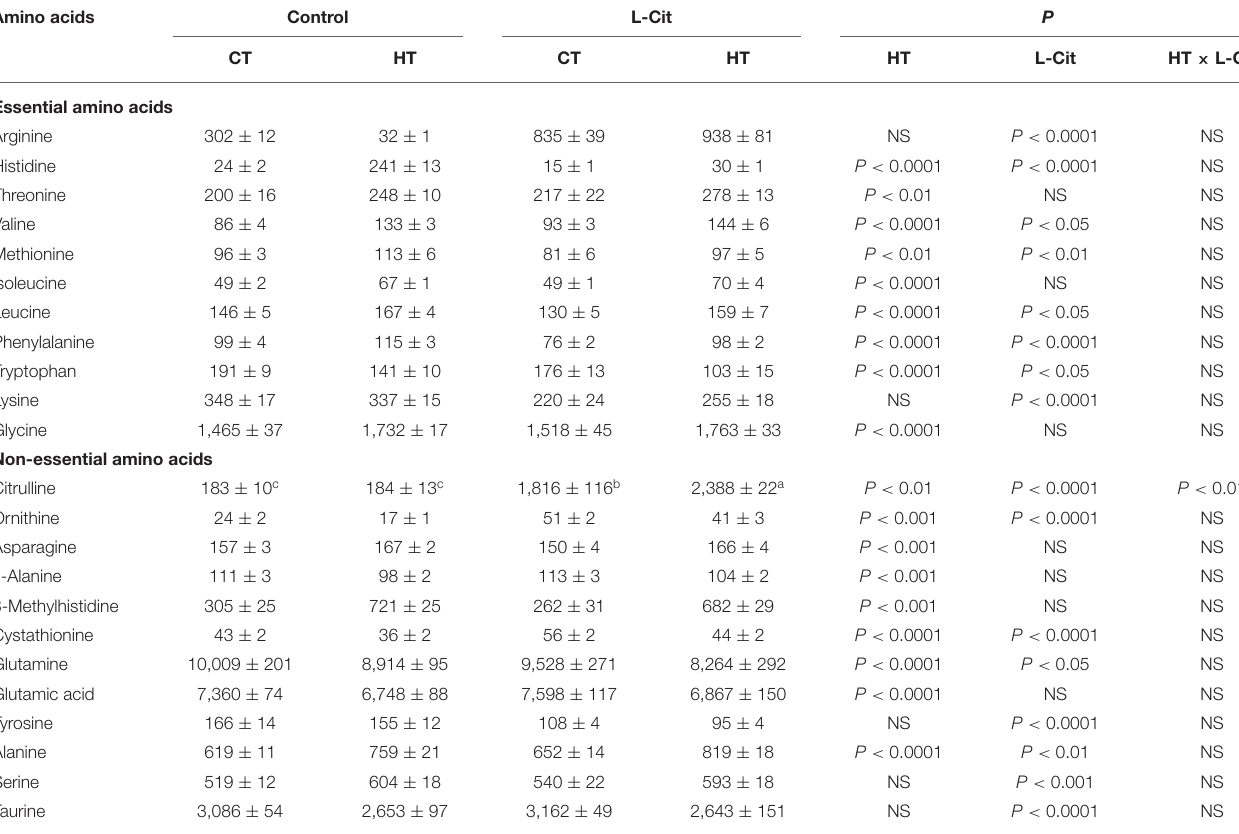
TABLE 1 | Effects of oral administration of L-Cit on free amino acid concentrations in the diencephalon of broilers. Amino